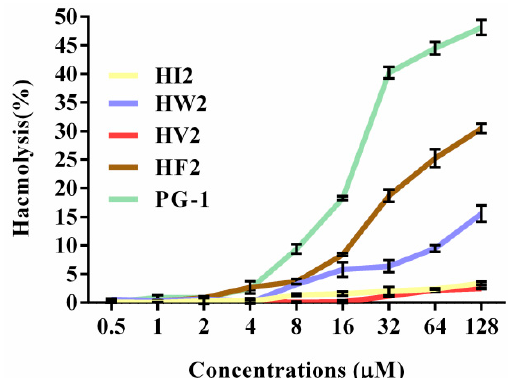
Figure 3. Hemolytic activity of peptides against hRBCs. The peptides were incubated with hRBCs in a 96-well microtiter plate and measured for optical density (OD) at 570 nm. For negative and positive controls, hRBCs in PBS and 0.1% Triton X-100 were used, respectively. Table 2. MIC, MHC and TI of the peptides .